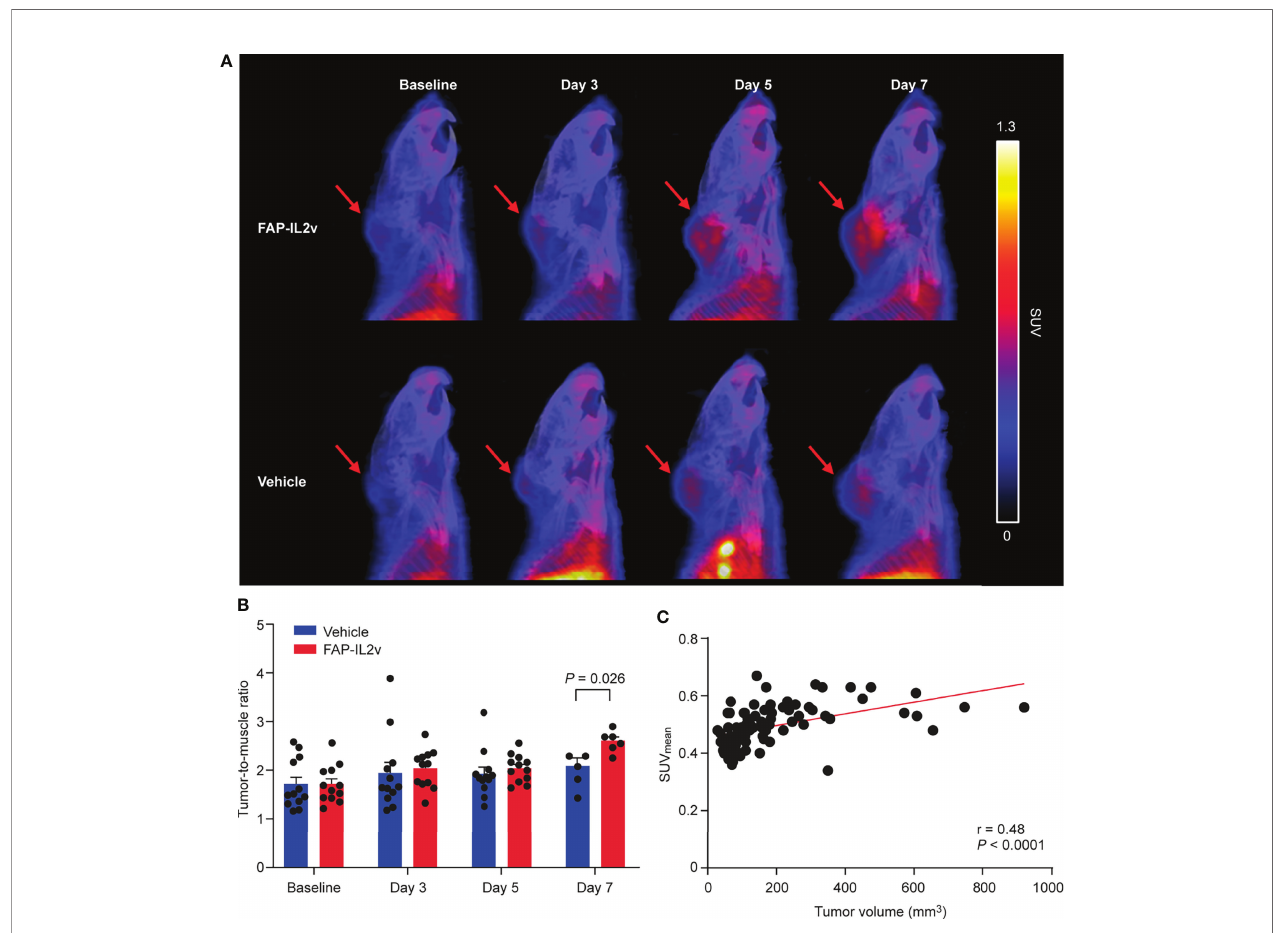
FIGURE 2 | Treatment with an IL-2 variant fused to fi broblast activation protein (FAP-IL2v) enhances [ 68 Ga]Ga-DOTA-Siglec-9 uptake in B16-FAP tumors. (A) Representative sagittal PET/CT images of FAP-IL2v-treated and vehicle-treated mice at baseline, and 3, 5, and 7 days after baseline imaging. Red arrows indicate B16-FAP melanoma tumors. (B) Quantitative analysis of PET/CT images showed that FAP-IL2v treatment increased the tumor-to-muscle ratio of [ 68 Ga]Ga-DOTA- Siglec-9 binding ( n = 6-12/group). (C) In vivo tumor uptake correlated well with tumor volume during the follow-up period ( n =